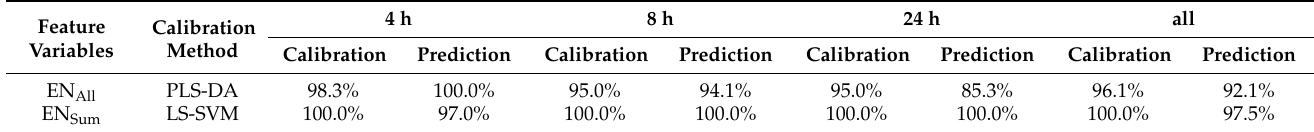
Table 2. Best models for identification of strawberries with impact